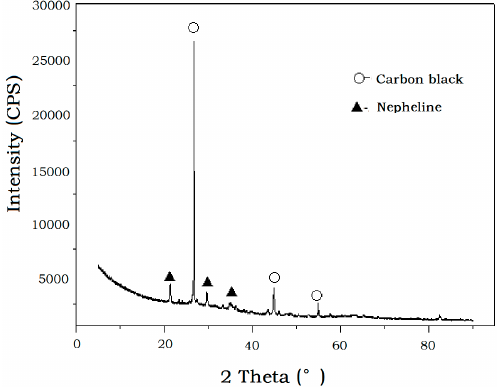
Figure 8. XRD pattern of tailing.